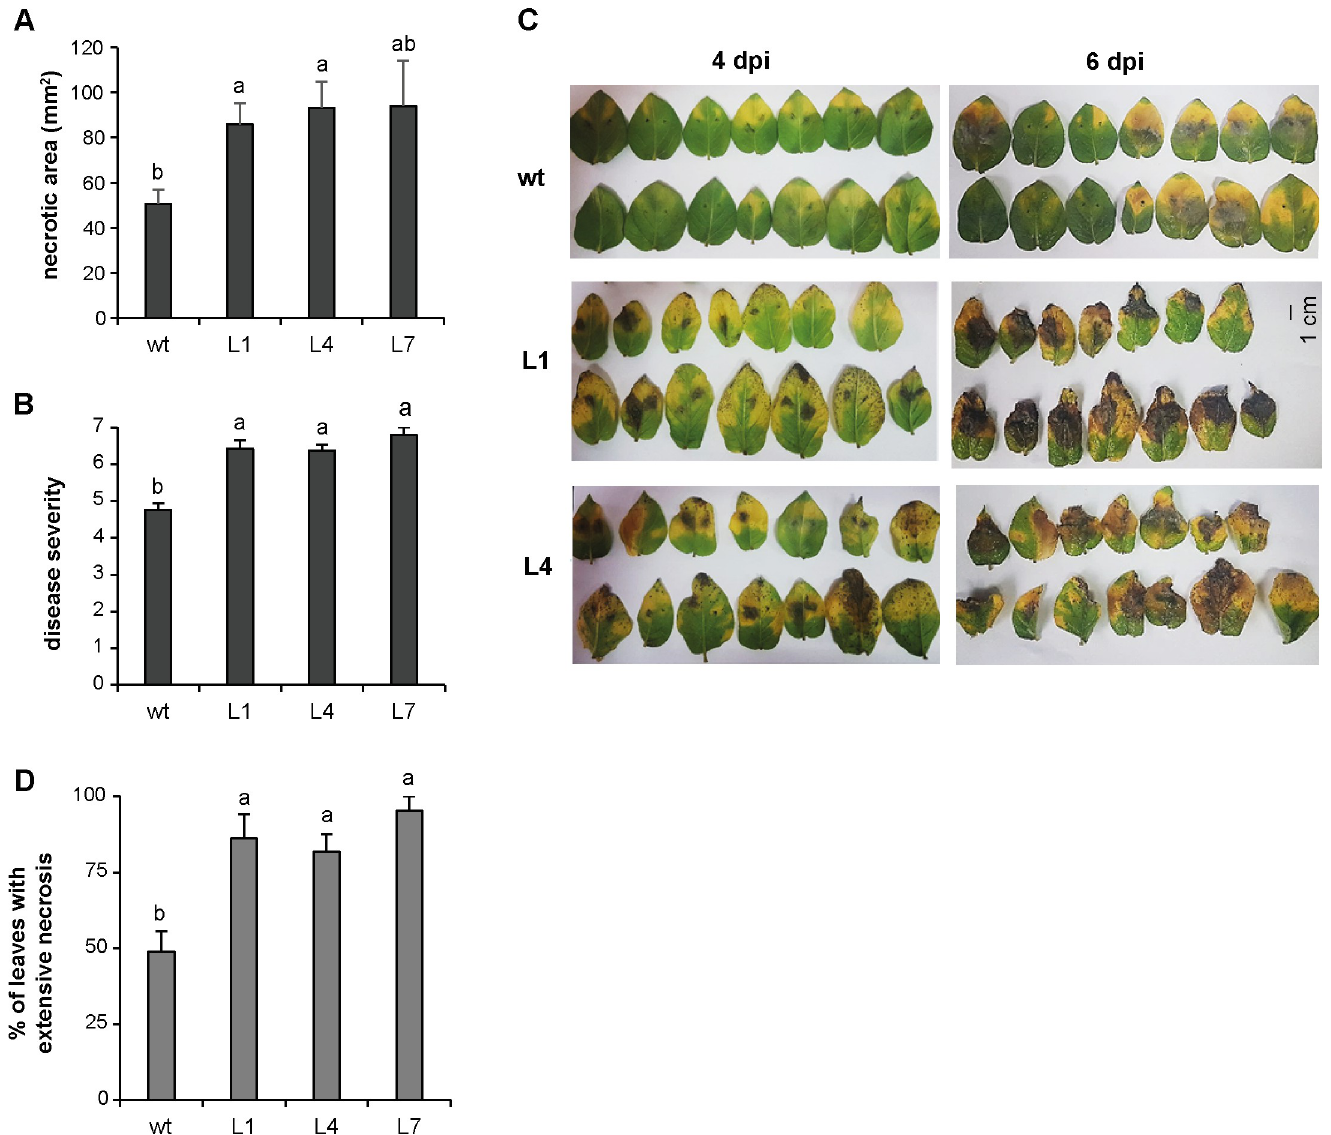
Fig 2. Susceptibility of StPP2Ac2b-OE plants to P . infestans . (A, B) Necrotic area and disease severity of detached leaves from wild type (wt) and PP2Ac2b-OE (L1, L4 and L7) plants four days after inoculation with P . infestans . (C) Representative images of detached leaves after four and six dpi. (D) Percentage of leaves with extensive necrosis in whole plants four dpi. Data are the mean ± SEM of of three independent experiments. Data were analyzed by one-way ANOVA followed by Bonferroni post-hoc test ( α = 0.05).